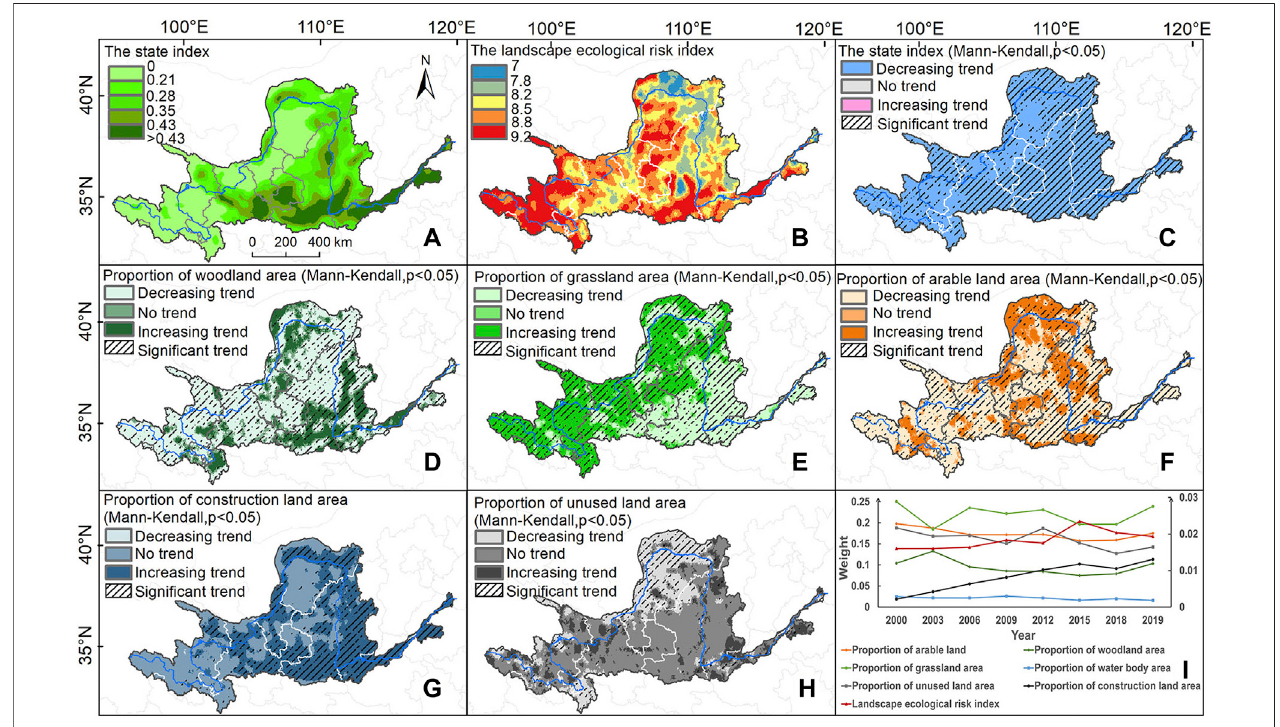
FIGURE3| Spatialdistributionofstateindex (A) ,spatial distribution oflandscapeecologicalriskindex (B) , Mann-Kendall testresults ofstate layerindicatorsat the 0.05 signi fi cance level (C – H) , the trend of weights of each indicator over time (I) . Note: The weight values of grassland, arable land and woodland correspond to the left axis of Figure 3I , and the weight values of construction land, water body and unused land correspond to the right axis of Figure 3I .